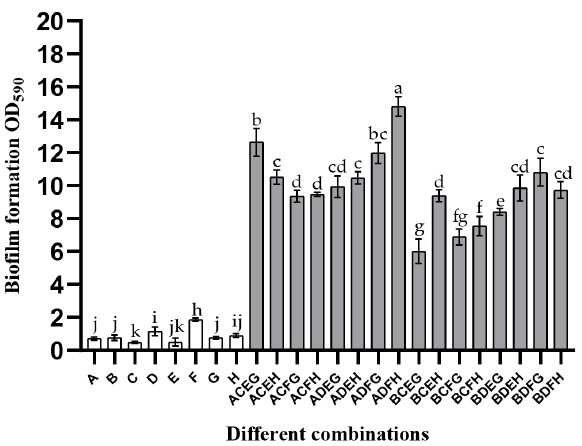
Figure 2. Strain specificity of the mixed-species biofilm. The uppercase letters A–H represent different